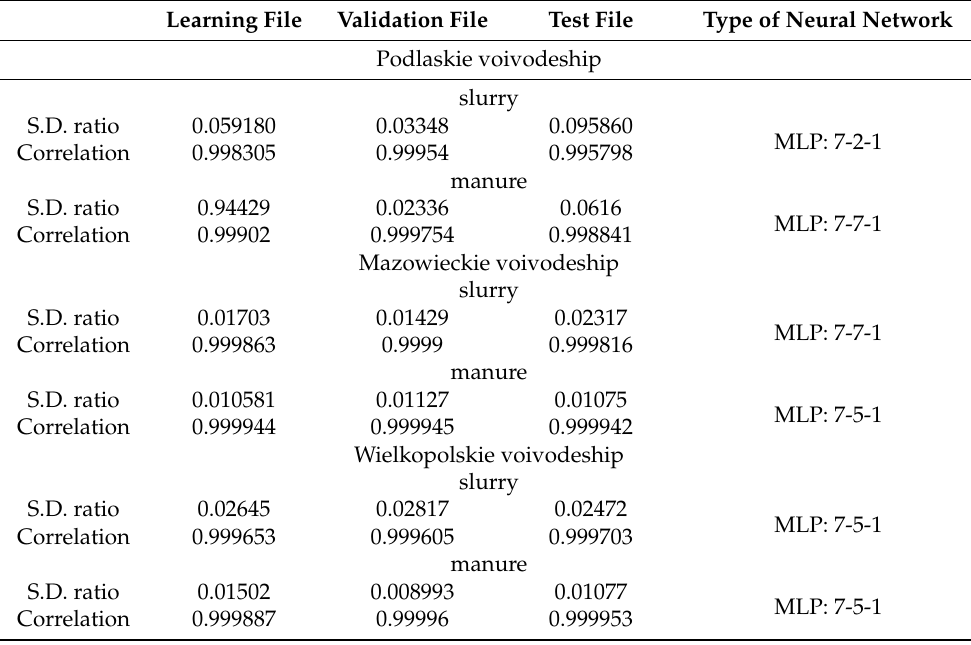
Table 4. Regression statistics of the obtained optimal neural models. S.D: ratio-quotient of standard deviations determined for errors and for data. Correlation standard: Pearson correlation coefficient between the results given by the generated neural model and the actual output values.